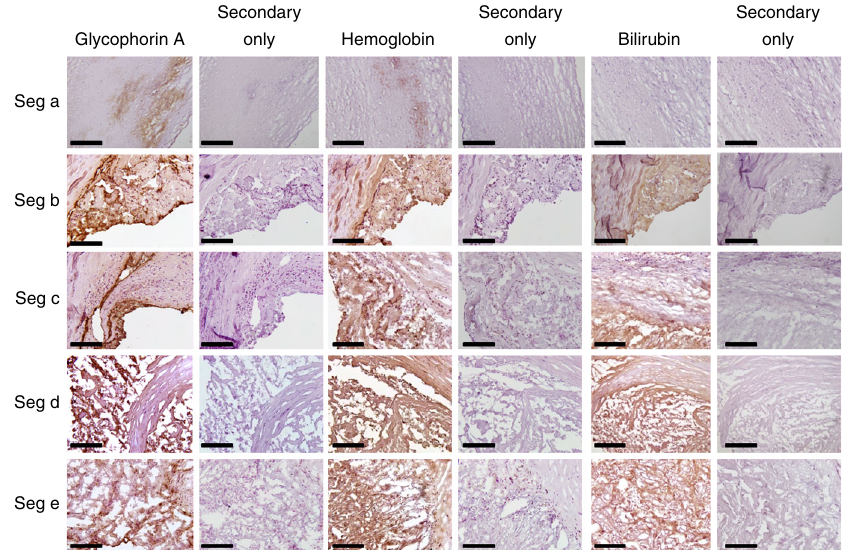
Fig. 6 Immunohistochemical staining of intraplaque hemorrhage markers in human CEA sample in fi ve cross-section segments (as shown in Fig. 1d and e). From left to right: Glycophorin A staining, secondary antibody only control for glycophorin A, hemoglobin staining, secondary antibody only control for hemoglobin, bilirubin staining, secondary antibody only control for bilirubin. Bilirubin was absent in seg-a but positive staining is seen in other segments, most pronounced in seg-d and seg-e. Brown color indicates a positive staining. Controls were performed with secondary antibody only. Experiments were performed eight times and one representative example is shown. Scale bars indicate 50 µ